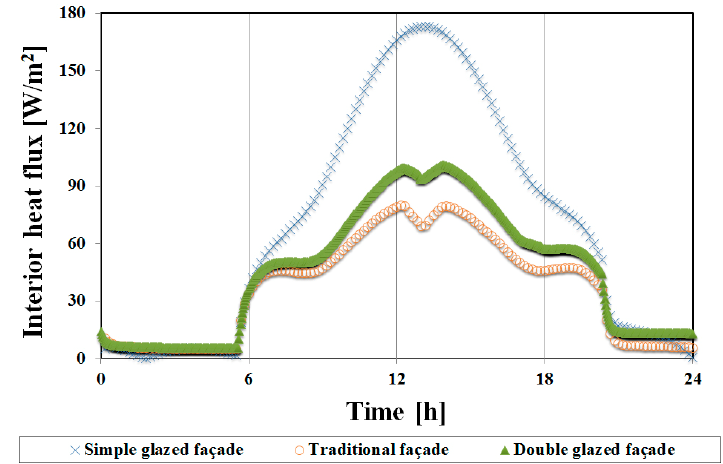
Figure 1. Example of interior heat fluxes for different types of